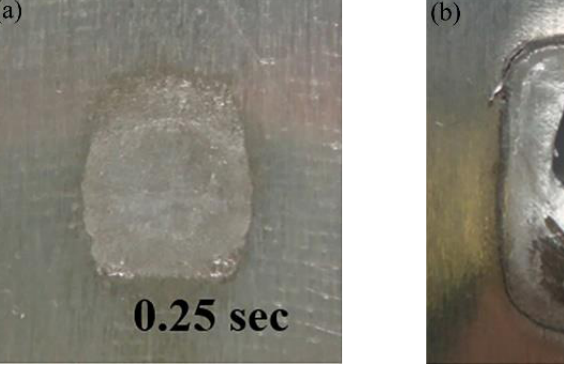
Figure 22. Joint strength using C-tip and K-tip at 1.0 s welding time [49].